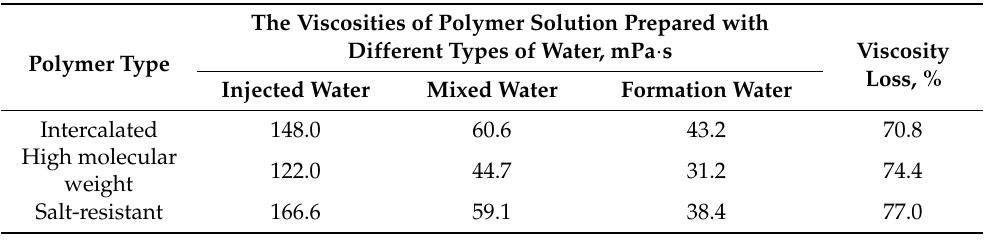
Table 2. Thickening effect of intercalated polymer in water with different